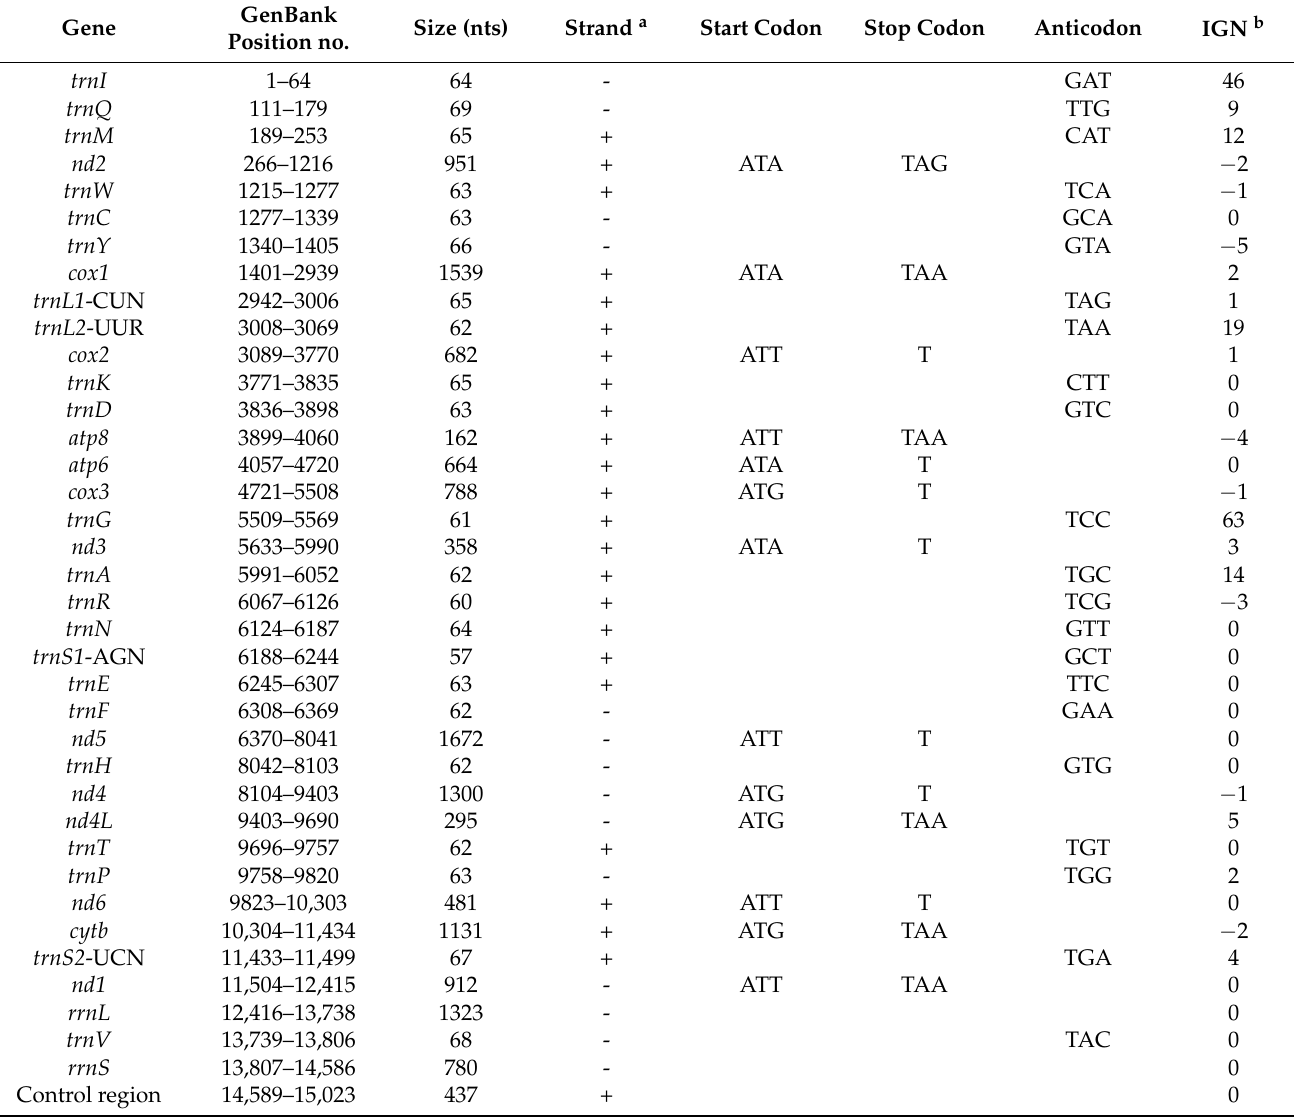
Table 1. Annotation of the mitochondrial genome of L. grossipedia